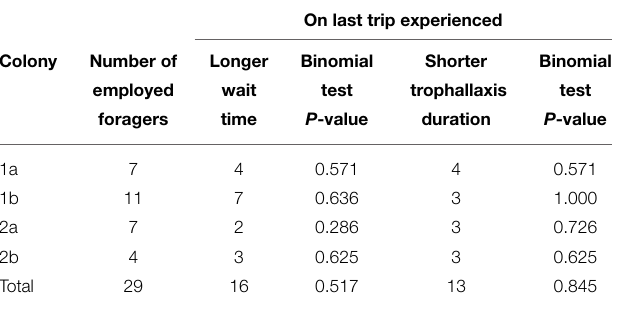
FIGURE 2 | Difference between the last and average trophallaxis duration/wait time during a forager’s employment period.